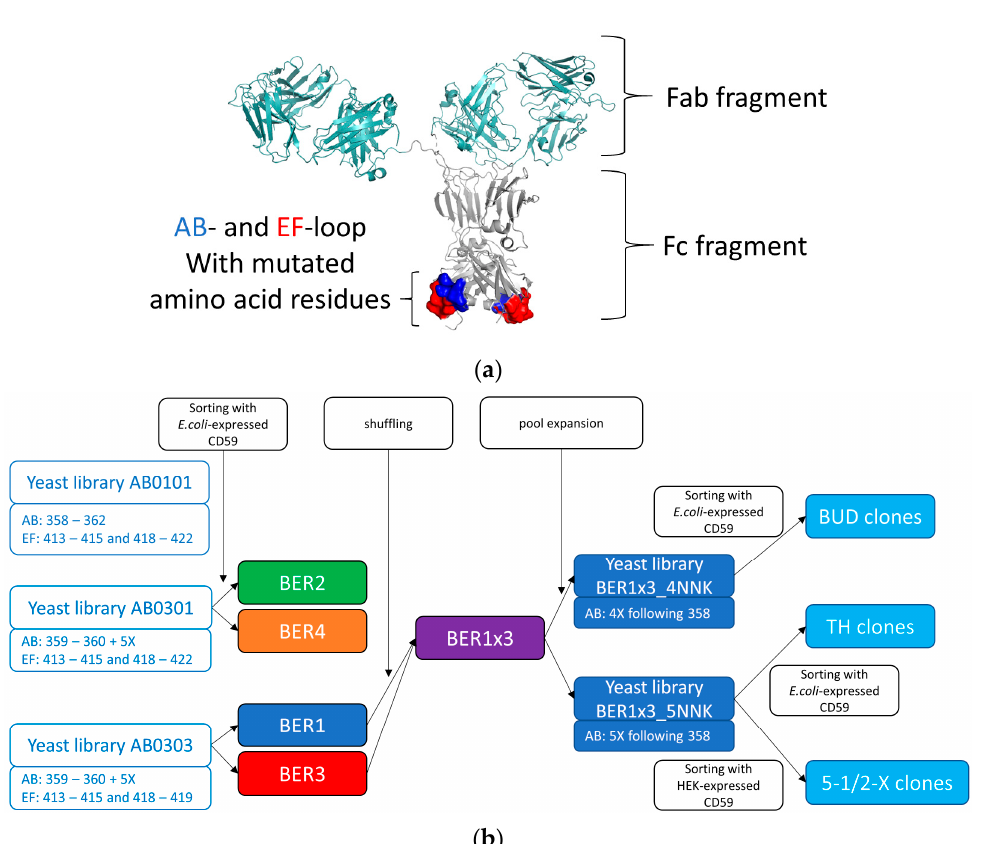
Figure 1. mAb 2 bispecific molecules contain antigen binding Fc fragments (Fcabs), which can be derived from yeast Fcab libraries: ( a ) Model of a mAb 2 antibody: Fab fragment in light teal, Fc in gray, and modified residues in the Fc-CH3 domain highlighted in blue (AB loop) and red (EF loop). The Figure was prepared using PyMOL version 2.5 (Schrödinger LLC.) based on PDB:1HZH; ( b ) Scheme of selection and pool expansion of CD59-reactive Fcabs (EU numbering scheme for antibody amino acids is used).